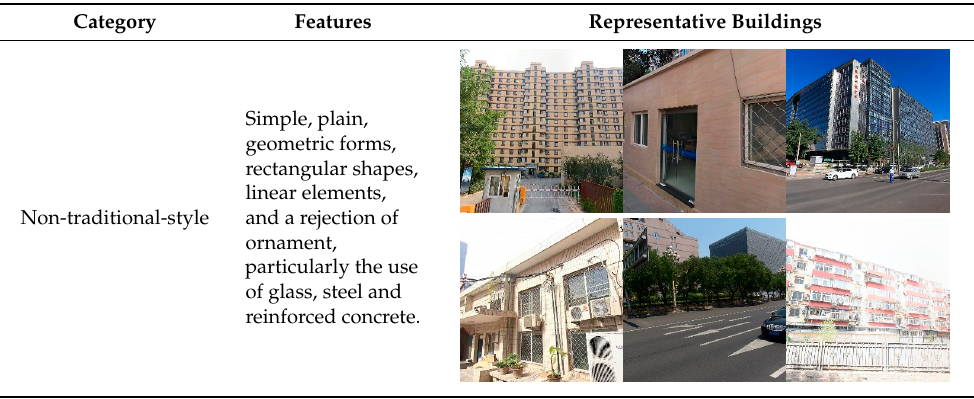
Table 2. Description of datasets.